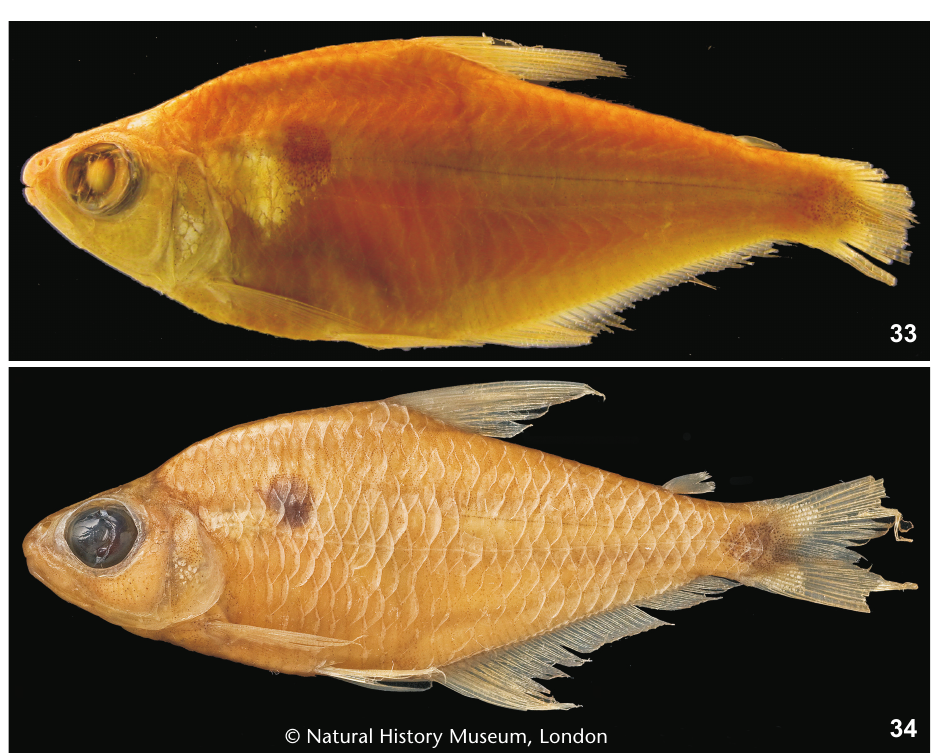
Figuras 33-34. Phenacogaster megalostictus : (33) FMNH 53530, holótipo, 49,2 mm CP, Tumatumari Rio Potaro inferior, Guiana. (34) BMHN 1974.5.22:82-85, Rio Potaro, 48,8 mm